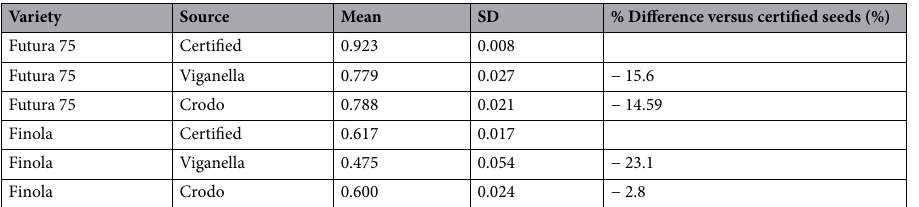
Table 1. Mean weight (g) and standard deviation (SD) of a representing sample of 50 seeds from Finola and Futura 75 varieties, obtained from the experimental fields of Viganella and Crodo. Certified seeds are included as a reference. The last column reports the percentage of weight difference of harvested seeds respect with certified seeds of the same hemp